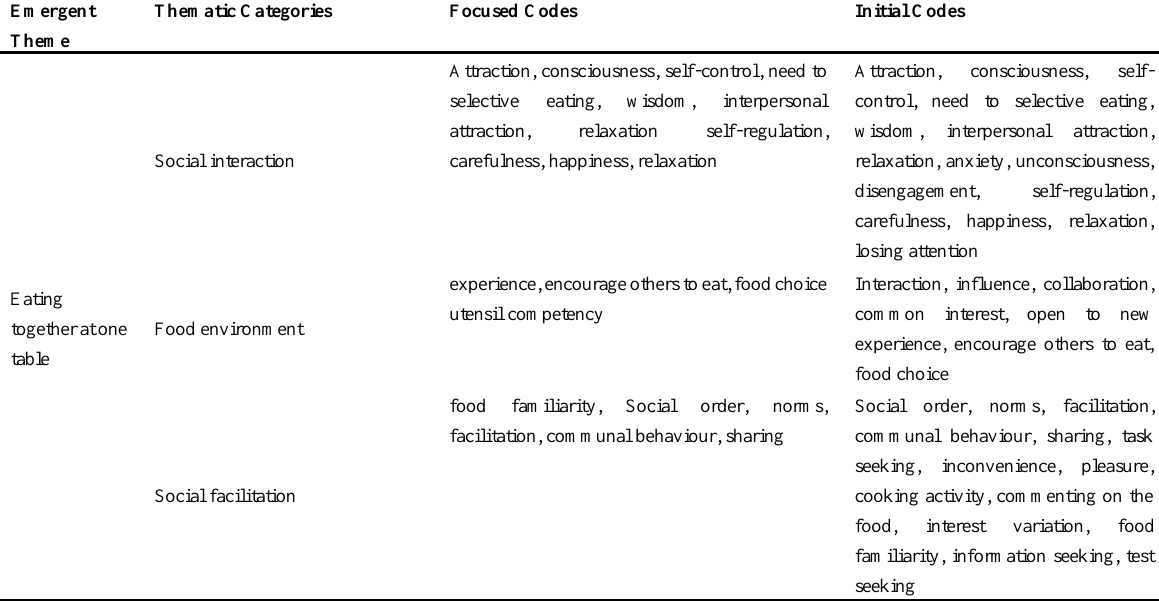
Table 2 : Results of Data Analysis and Interpretive Coding